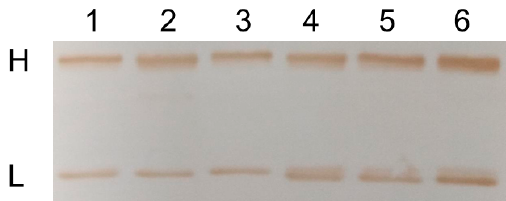
Figure 4. Conjugation efficiency of six ofatumumab (OFA) variants. Western blot analysis was performed for determination of monomethyl auristatin E (MMAE) levels of light and heavy chains. Lane 1, H/L-LPETG; Lane 2, H/L-G 4 SLPETG; Lane 3, H/L-(G 4 S) 2 LPETG; Lane 4, H/L-LPETGGH 6 ; Lane 5, H/L-G 4 SLPETGGH 6 ; Lane 6, H/L-(G 4 S) 2 LPETGGH 6 . H, heavy chain; L, light chain.